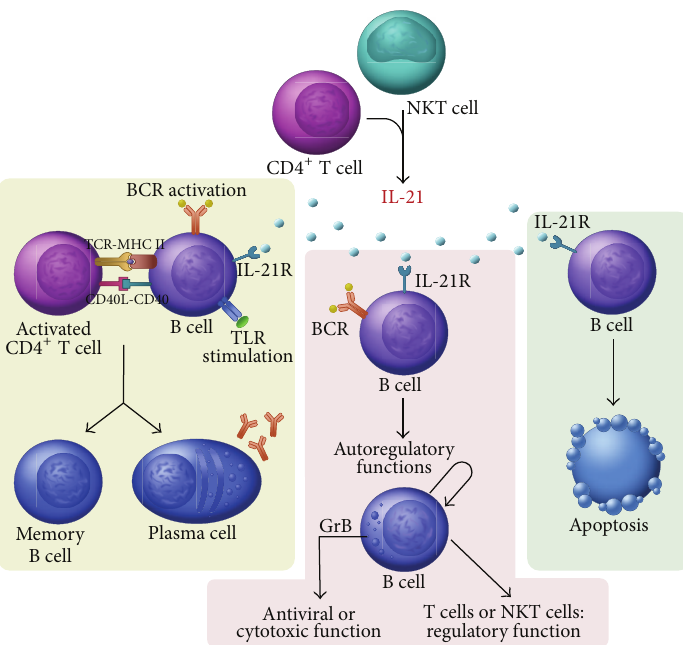
Figure 6: Possible results of interlukin-21 (IL-21) stimulation on B cells. In the presence of CD40 ligation and either a B cell receptor (BCR) or a Toll-like receptor signal, IL-21 stimulation fundamentally promotes B cell activation and differentiation into memory and plasma cells [6]. The combination of IL-21 stimulation and BCR engagement in the absence of CD40 ligation enables B cells to produce and secrete active form of granzyme B (GrB). GrB-producing B cells may acquire antiviral immune function and/or a regulatory function on themselves or other immune cells including T and NKT cells [15]. In the absence of both BCR engagement and T cell help, IL-21 stimulation induces B cell apoptosis